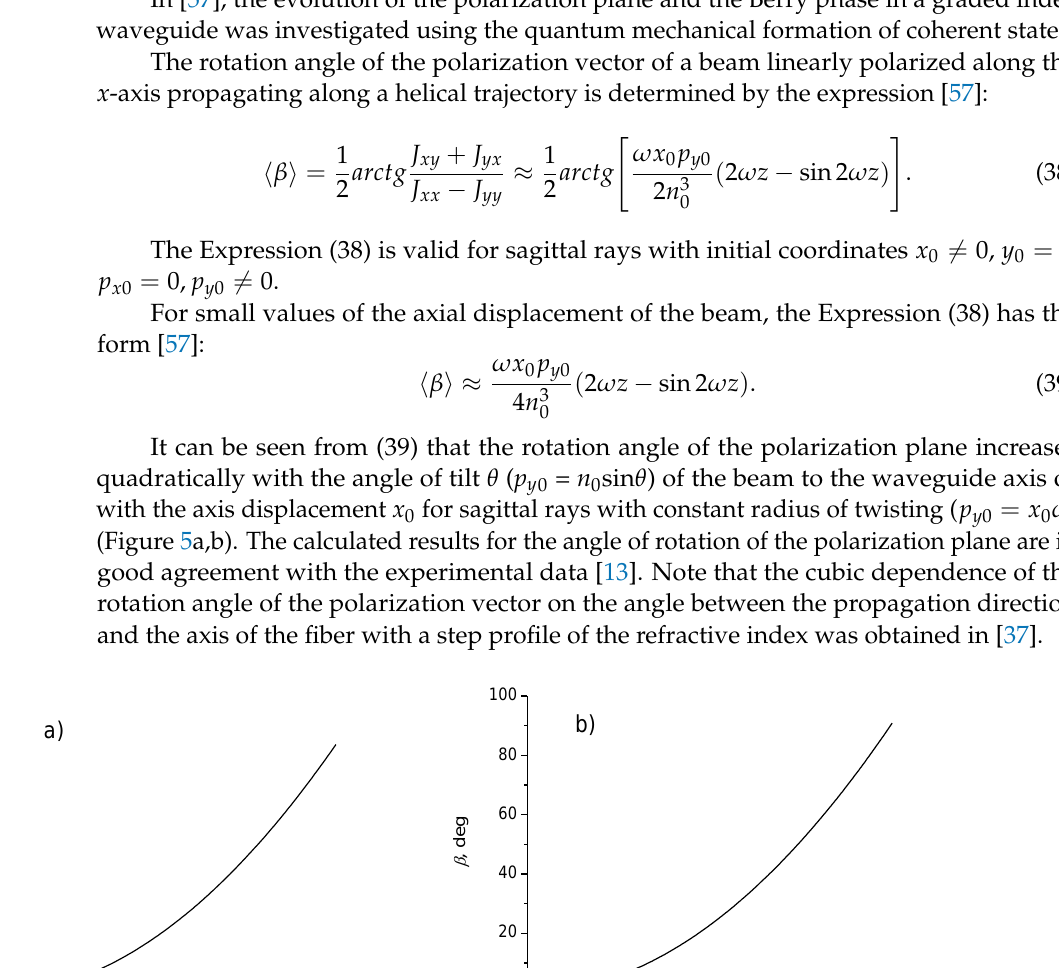
 of the beam relative to the 0